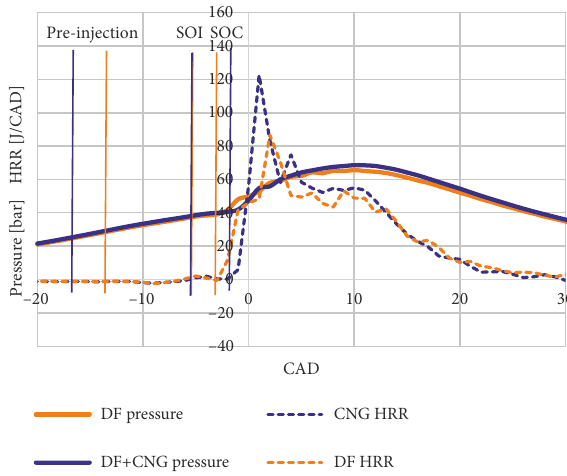
Figure 7. Combustion pressure and HRR at a 100%